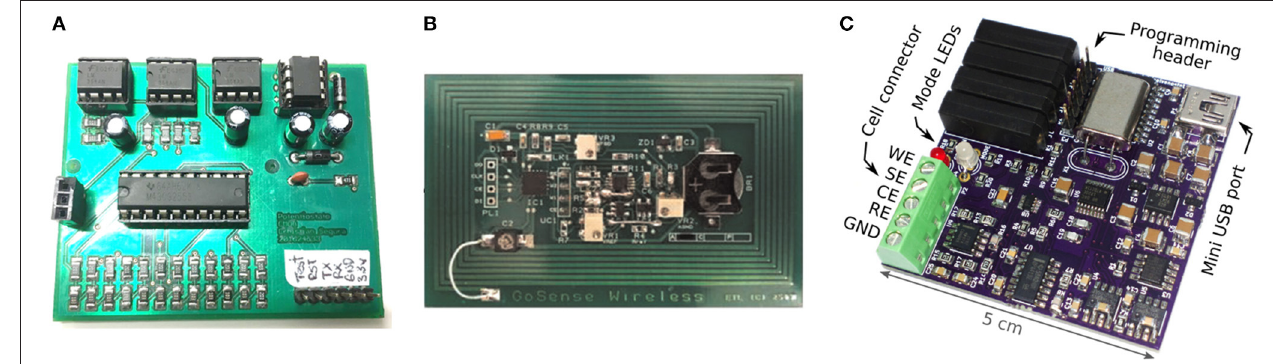
FIGURE 1 | Some of the portable devices for electrochemical measurements. (A) Miniaturized Potentiostat (Segura and Osma, 2017). (B) Wireless potentiostat (Steinberg et al., 2015). (C) USB Potentiostat Galvanostat (Dobbelaere, 2017).